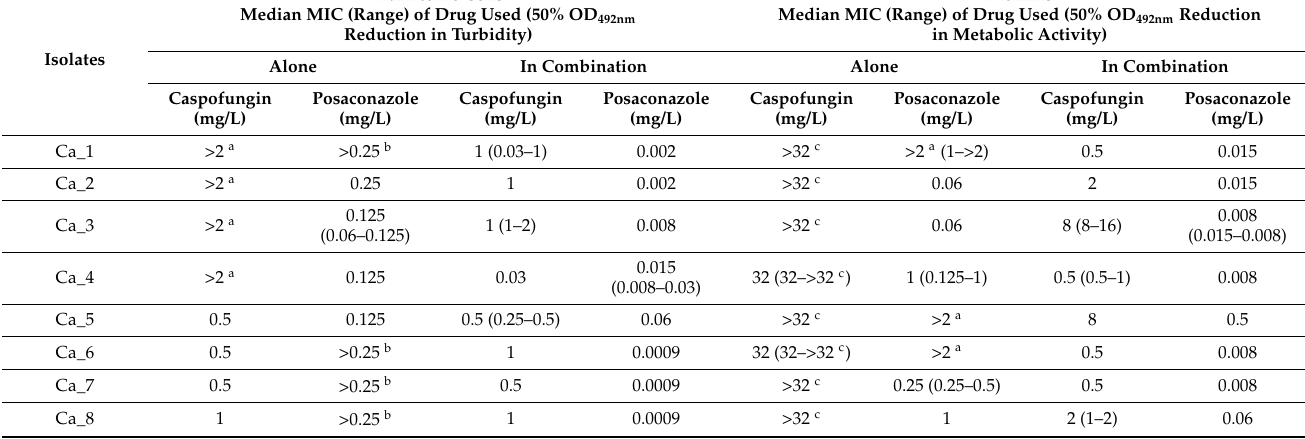
Table 2. Minimum inhibitory concentrations (MICs) of caspofungin alone and in combination with posaconazole against Candida auris planktonic cells and